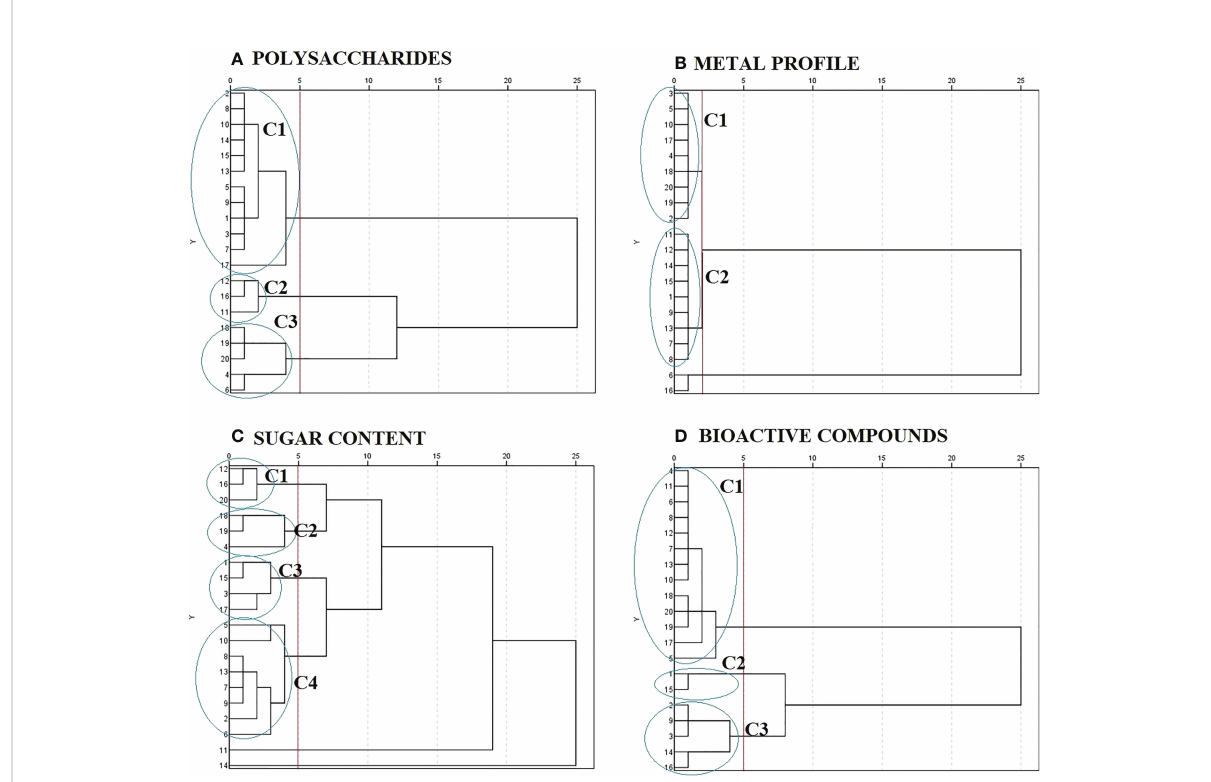
FIGURE 2 Dendrogram of hierarchical cluster analysis of seaweed extracts based on: (A) polysaccharides composition, (B) metal pro fi le, (C) sugar content, and (D) bioactive